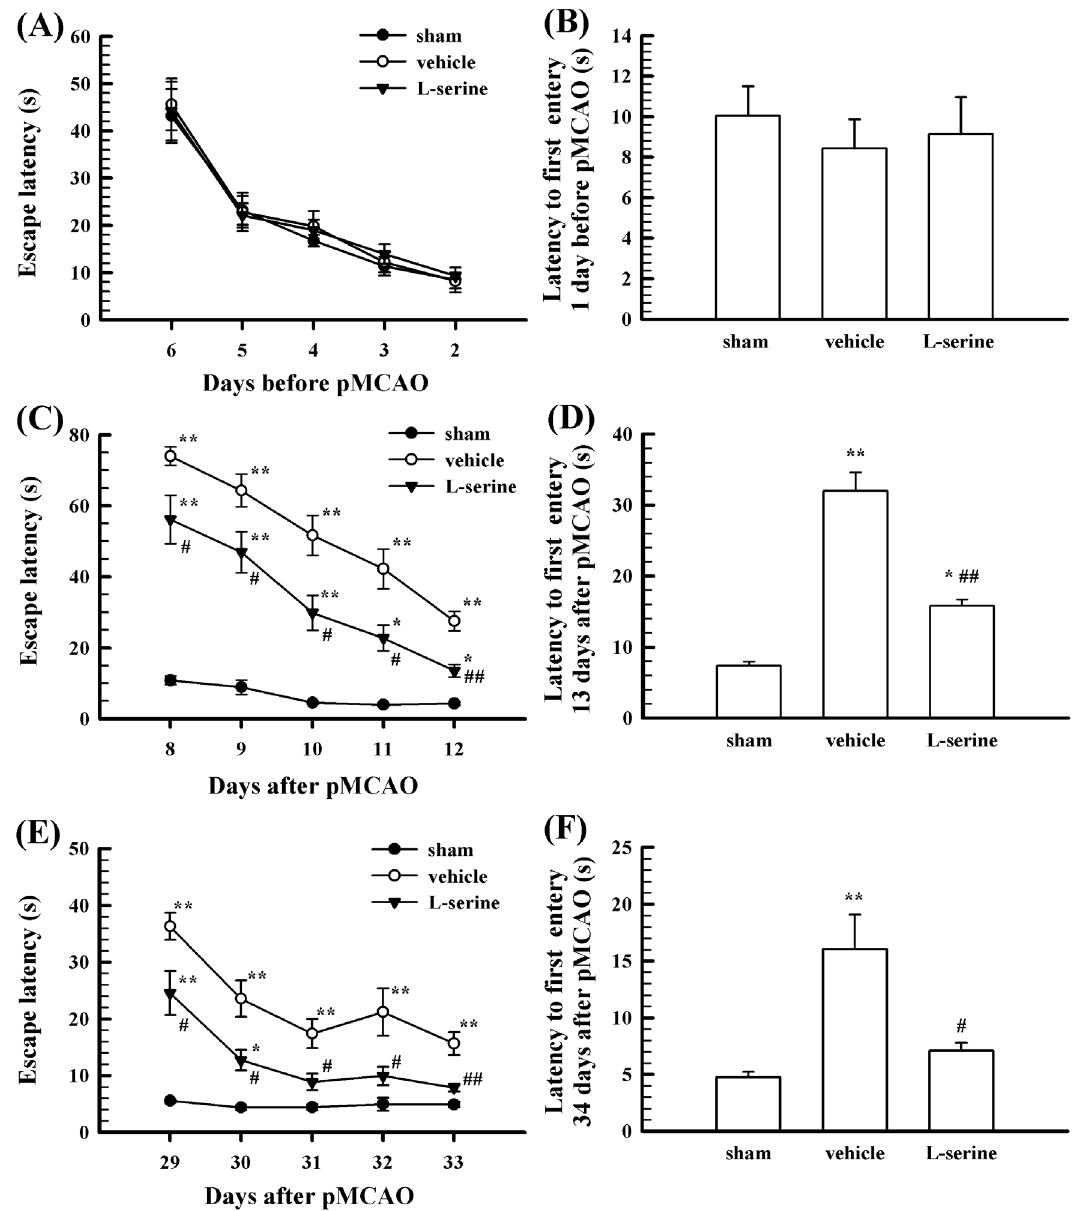
Figure 4. Effect of L-serine treatment on the learning and memory in rats after pMCAO (n=6–8). (A), (C), and (E): Escape latency to find the hidden platform during five consecutive days of training before or after pMCAO. (B), (D), and (F): Latency of the first time to enter the former platform location on the test day before or after pMCAO. * p , 0.05, ** p , 0.01 vs . sham-operated group; # p , 0.05, ## p , 0.01, vs . vehicle group.